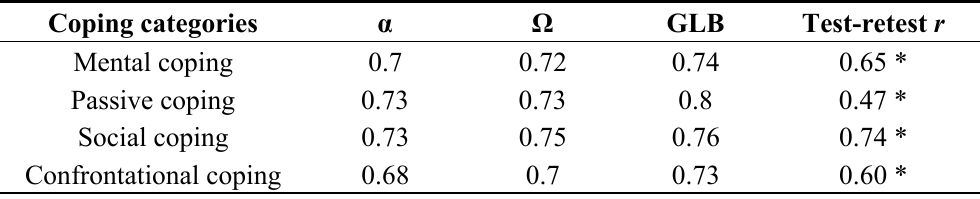
Table 5. (Test-retest) reliabilities of the CFA